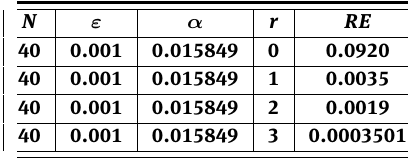
Table 1. The absolute errors Era for fixed α and for various value of